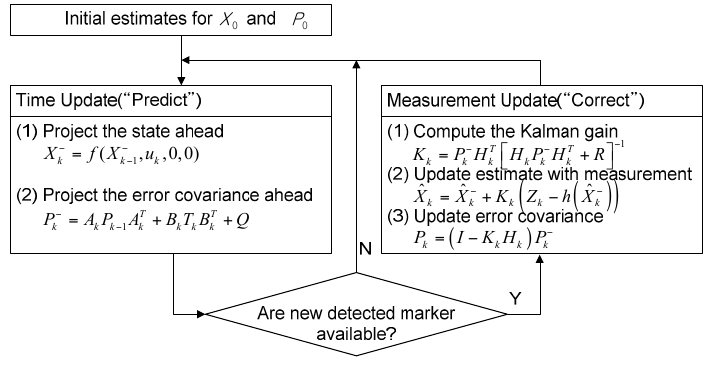
Figure 9. EKF flow chart.